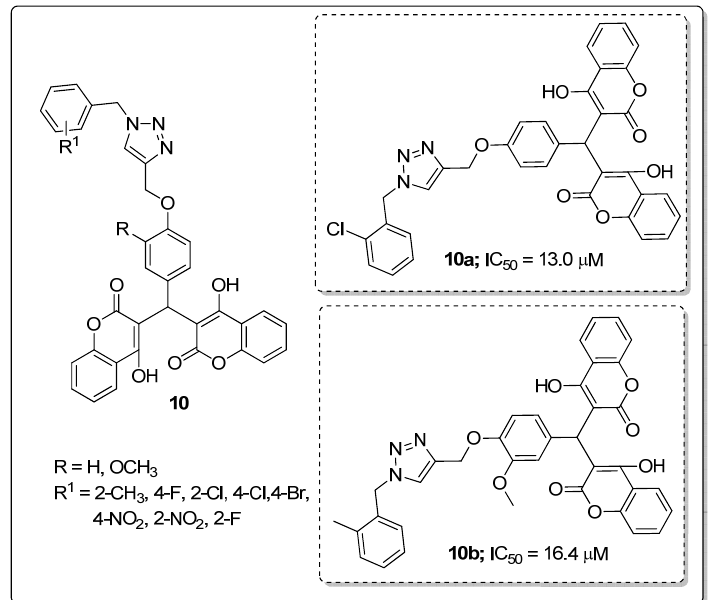
Figure 12. Most active 1,2,3-triazole-coumarin hybrids 10a and 10b as α -glucosidase inhibitors.